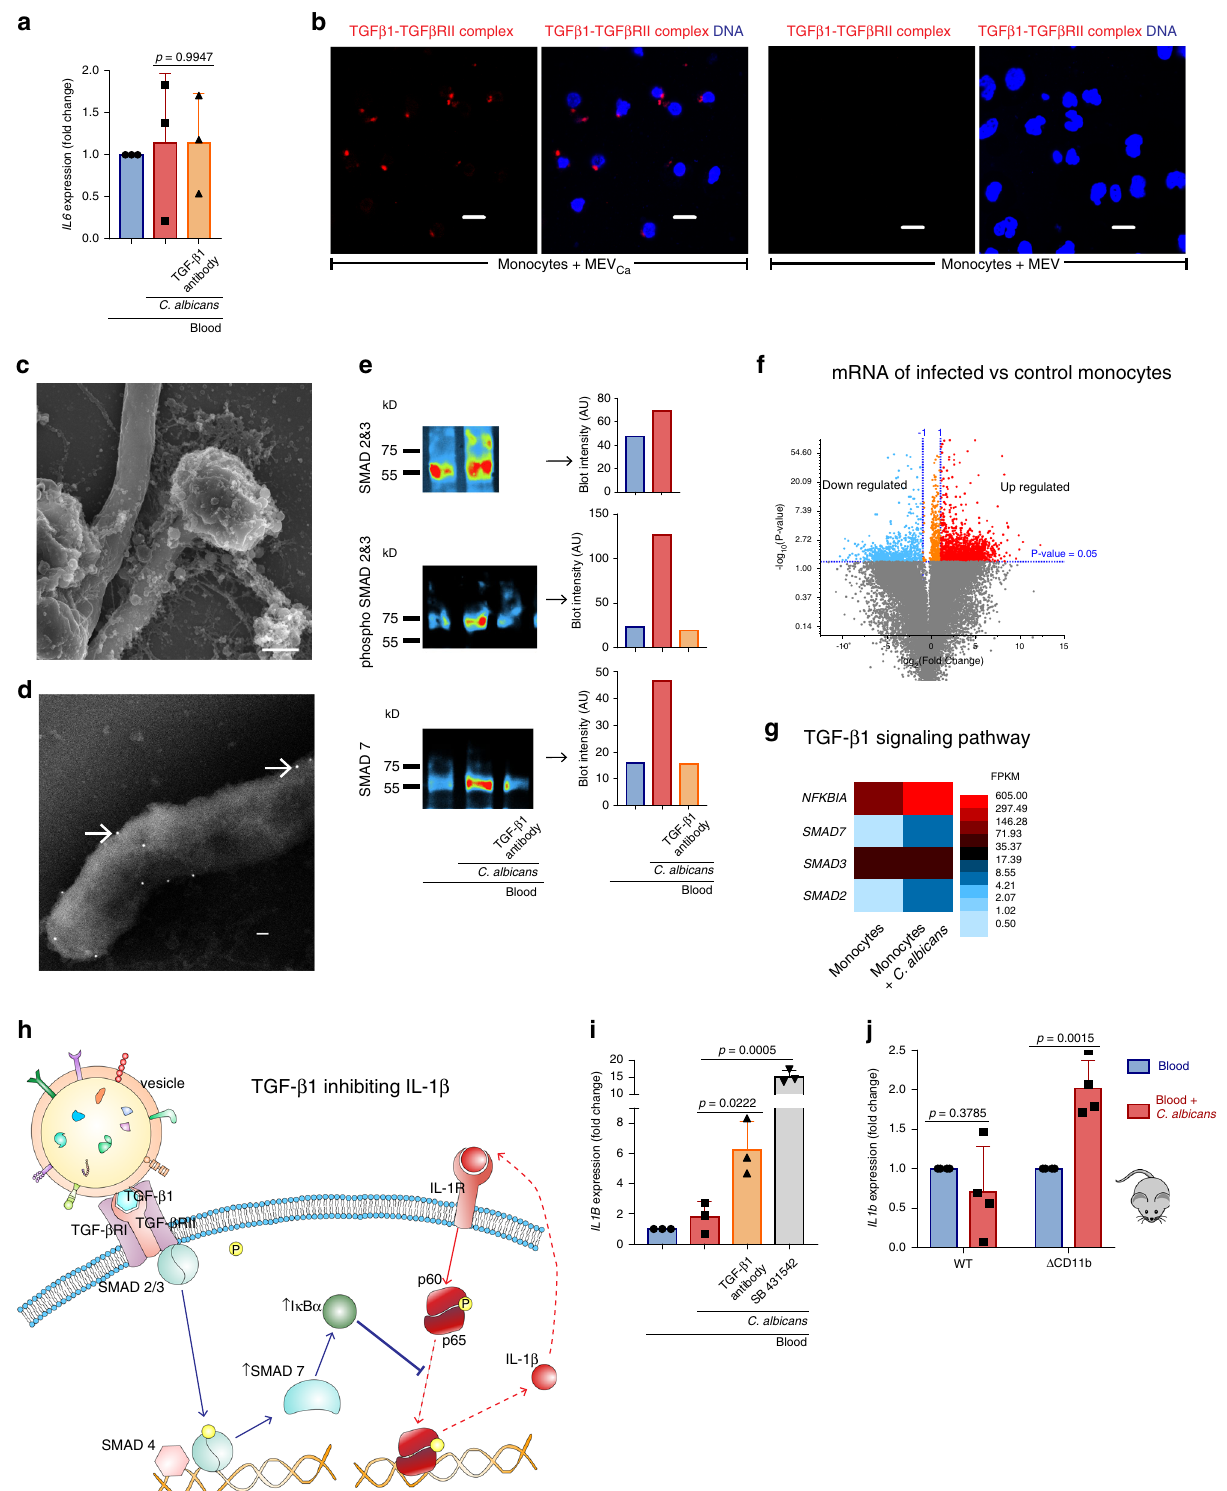
a neutralizing antibody, SMAD2/3 phosphorylation was inhibited (Fig. 6e). As SMAD2/3 phosphorylation leads to the upregulation of SMAD7, which subsequently signals through NF- κ B 23 , we also determined the expression of SMAD7 by western blot analysis. SMAD7 was substantially upregulated during C. albicans infection, and was reduced in the presence of an anti-TGF- β 1 antibody (Fig. 6e).